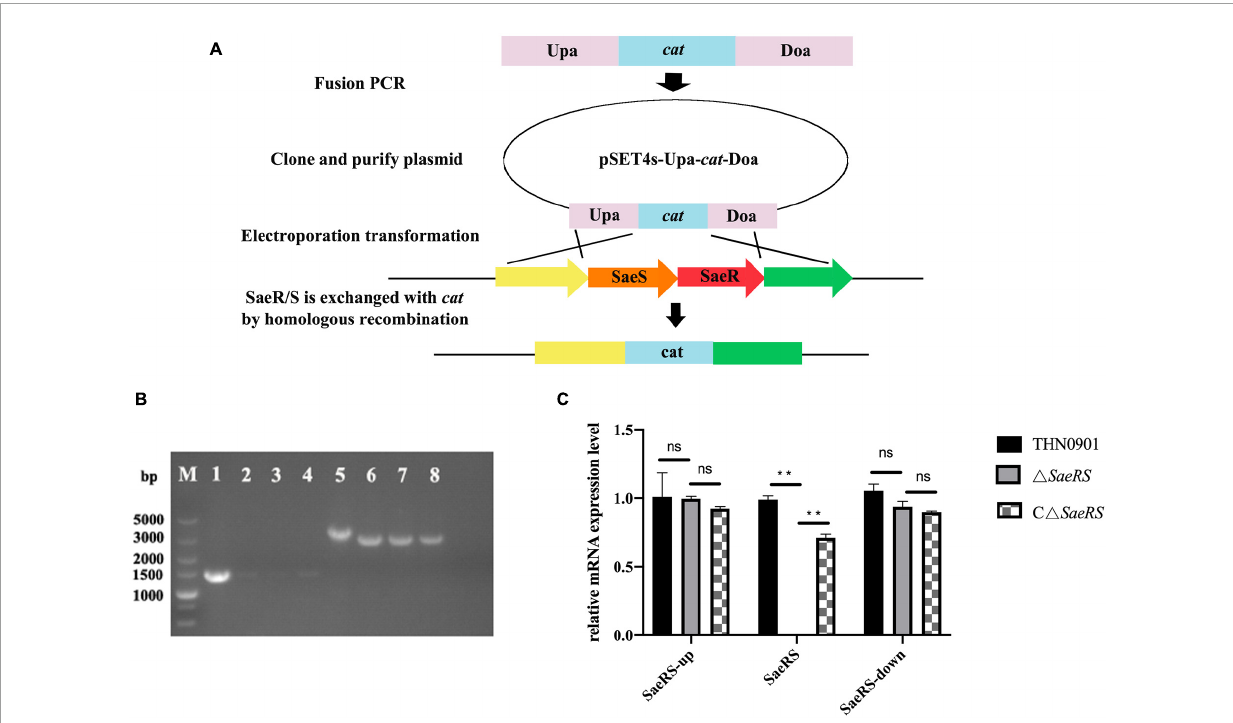
FIGURE1 (A) Construction of the SaeRS gene deletion strain of S. agalactiae THN0901 by homologous recombination. (B) Detection of the (cid:49) SaeRS mutant by the polymerase chain reaction (PCR). Lanes 1–4 using the primers Sae-F and Sae-R; Lanes 5–8 using the primers Sae-up-F and Sae-down-R; the primer sources used in lanes 1–4 are upstream homologous arm and downstream homologous arm. The primer sources used in lanes 5–8 are WP-000703870.1 and AK1948 13.1. Lane M is DL5000 DNA marker; Lane 1 and 5 is S. agalactiae THN0901, Lane 2 and 6 is 5th-generation (cid:49) SaeRS ; Lane 3, and 7 is 10th-generation (cid:49) SaeRS , Lane 4 and 8 is 15th-generation (cid:49) SaeRS , respectively. (C) Relative messenger RNA (mRNA) expression level of gene expression up and down stream of SaeRS among three strains. Each experiment was performed in triplicate, and data were presented as mean ± standard deviation (SD), *: 0.01 < P < 0.05, **: P < 0.01.